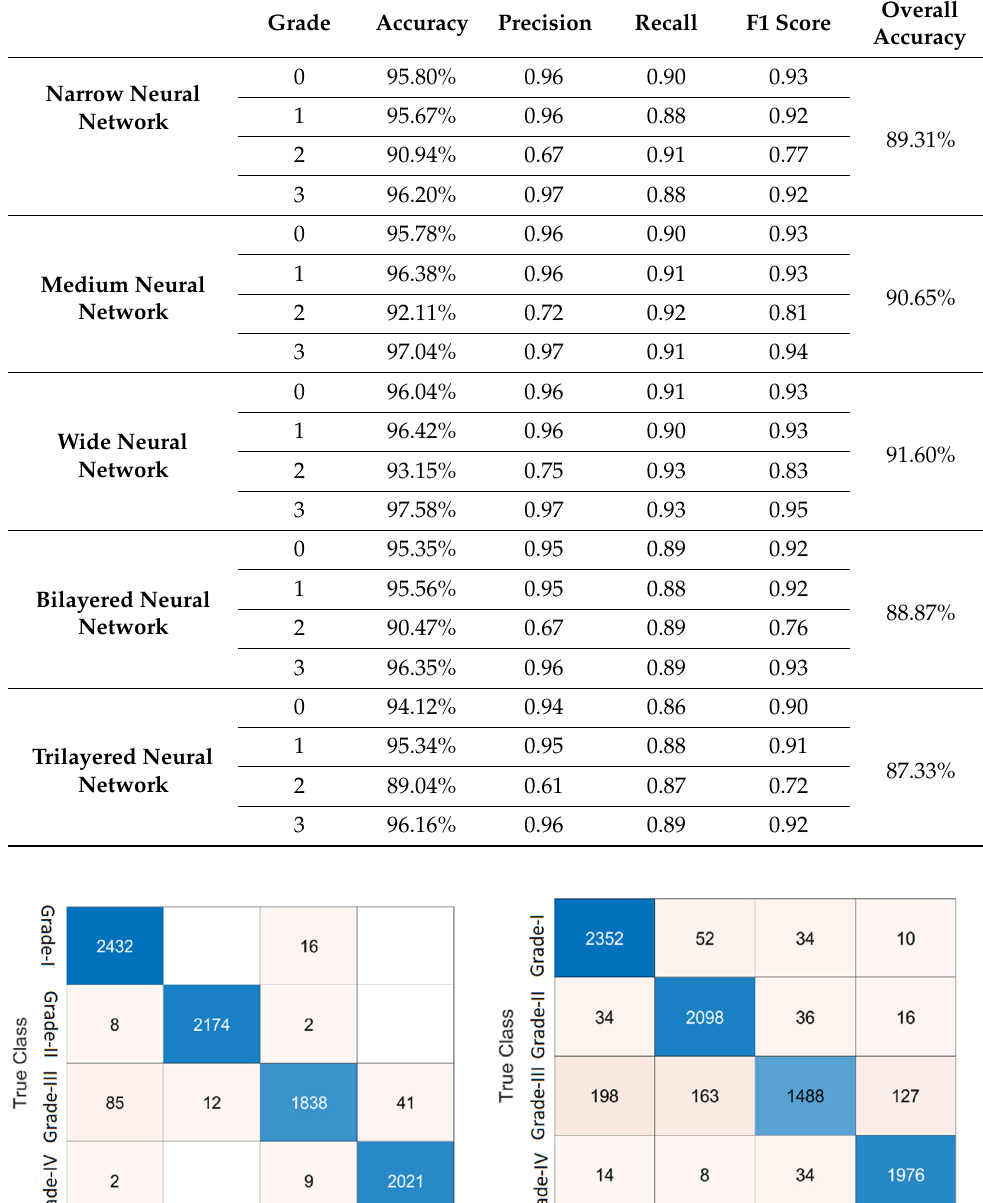
Table 8. Classification results on 10-fold cross-validation using NN classifier.